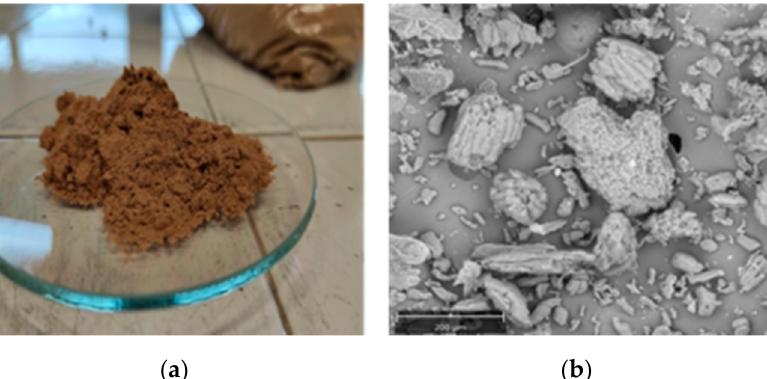
Figure 1. ( a ) HS powder; ( b ) scanning electronic microscope (SEM) image of HS (scale marked as 200 μ m).